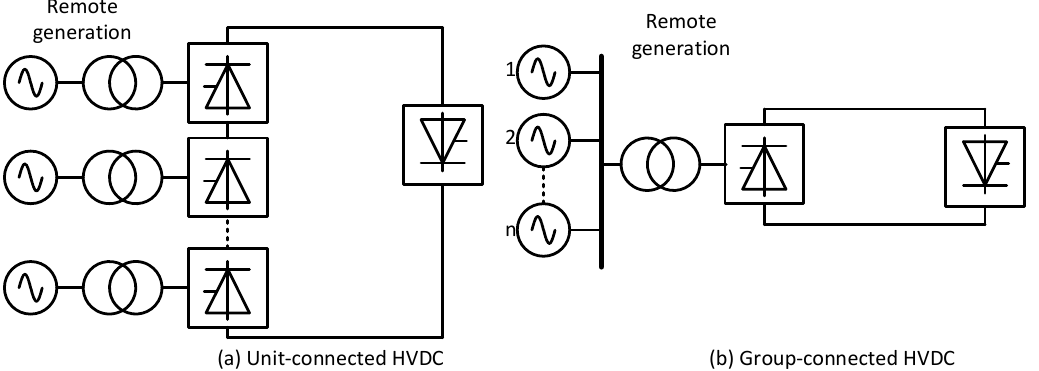
Figure 10. HVDC schemes for remote generation: ( a ) Unit connected HVDC scheme; ( b ) Group connected HVDC scheme.